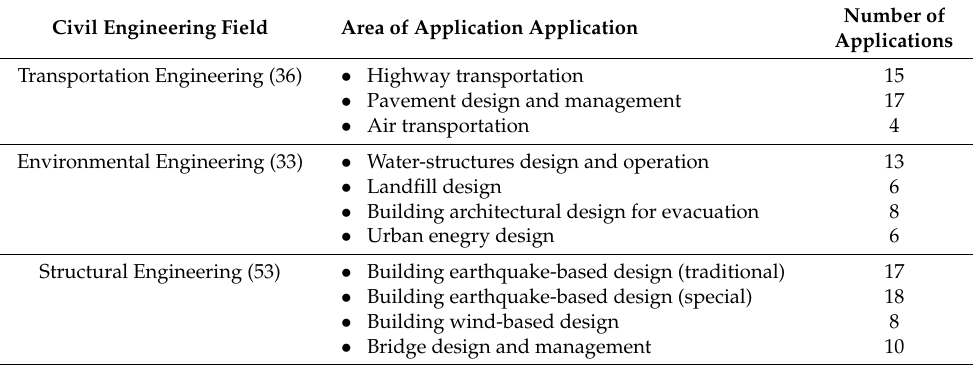
Table 1. Summary of the number of applications reviewed in various civil engineering